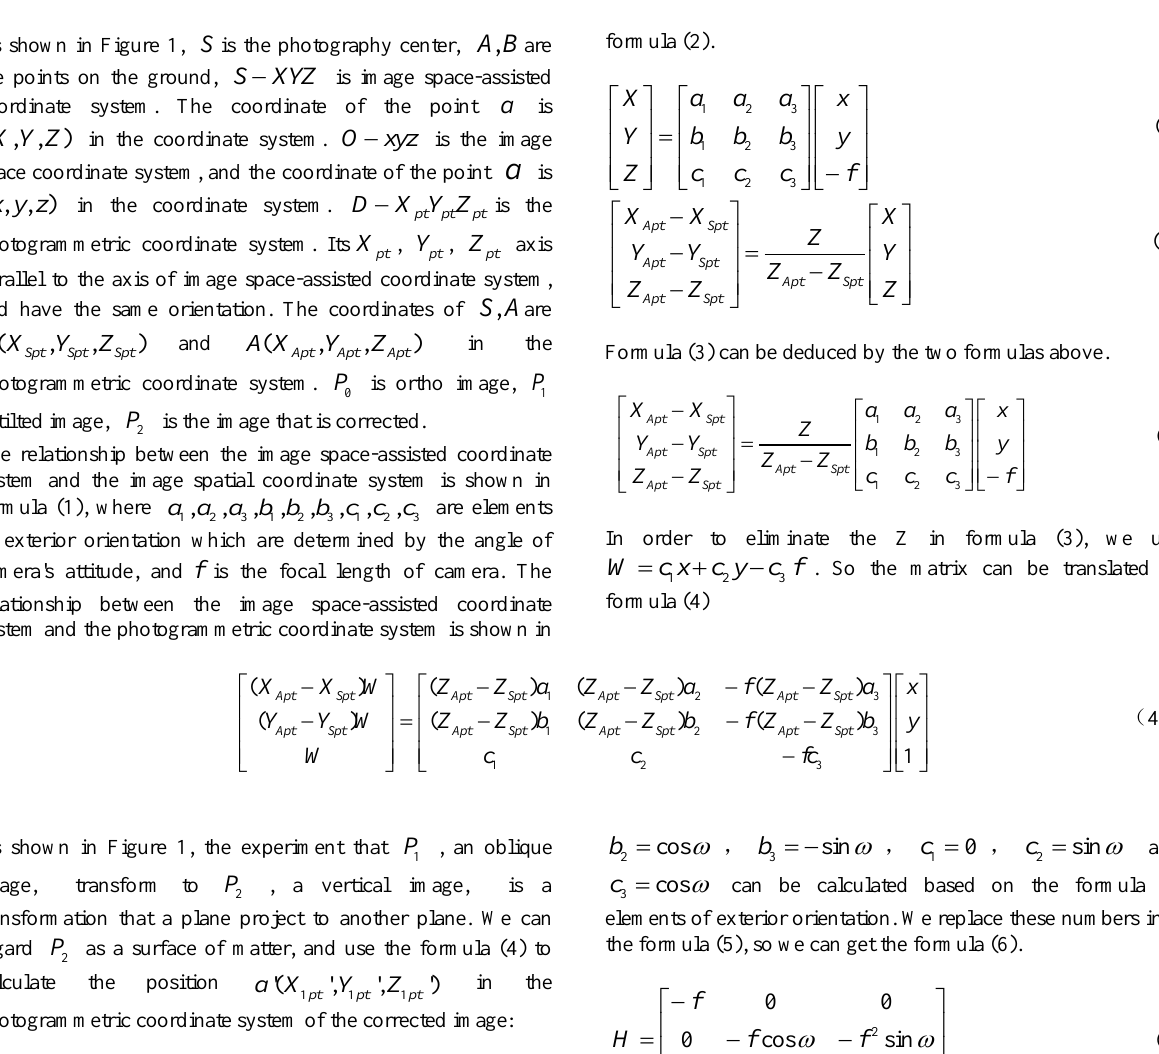
Figure 1. Non-relative parallel conformational projection